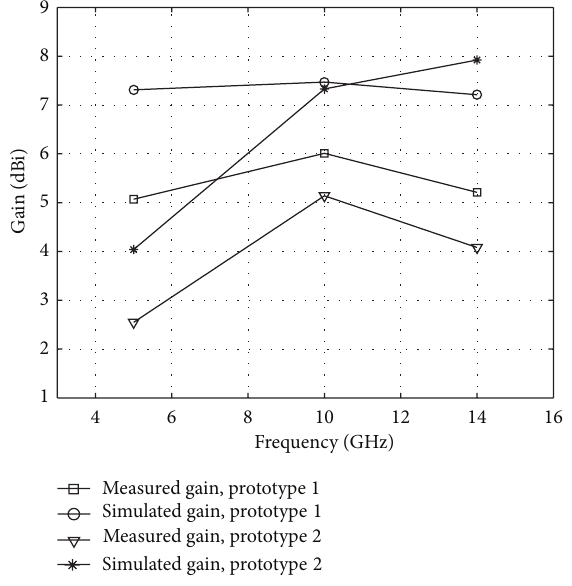
Figure 29: Simulated and measured gain for both proposed planar directional UWB antenna